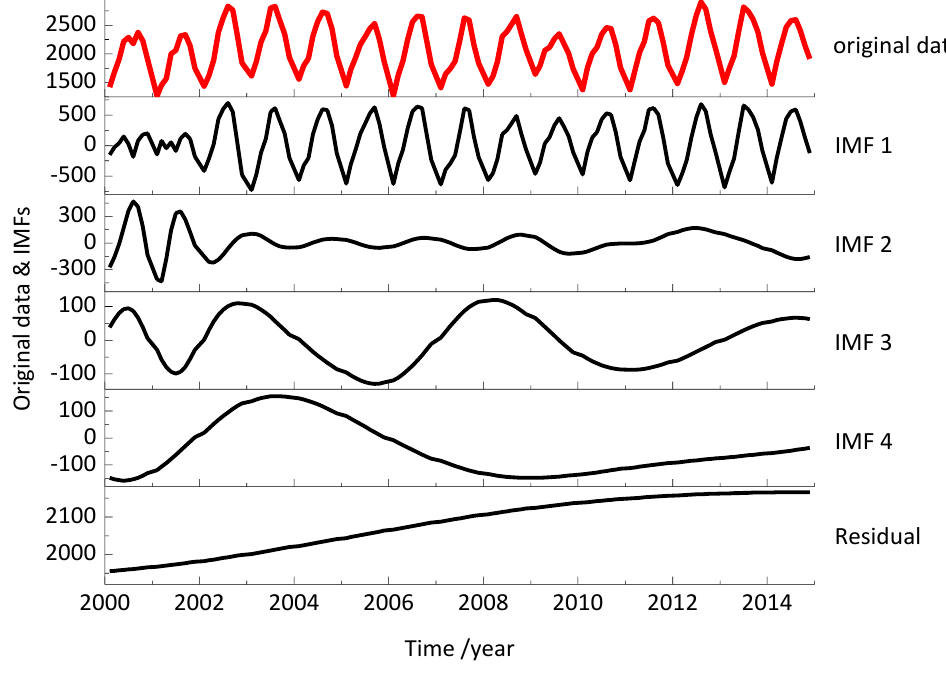
Figure 3. Original time series and EMD intrinsic fractions (including residual) of the EVI of Steppe Grassland, 2000–2014.